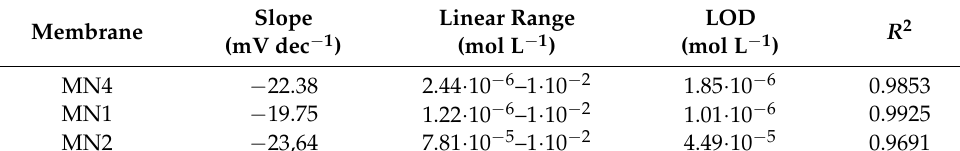
Table 5. Test results using membranes modified with magnetite and hematite NPs. Membrane